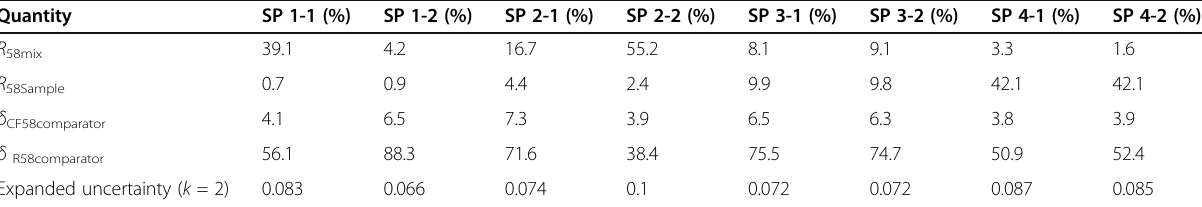
Table 7 Uncertainty budget indexes of simulated CRM 112A/CRM 149 IDMS mixtures